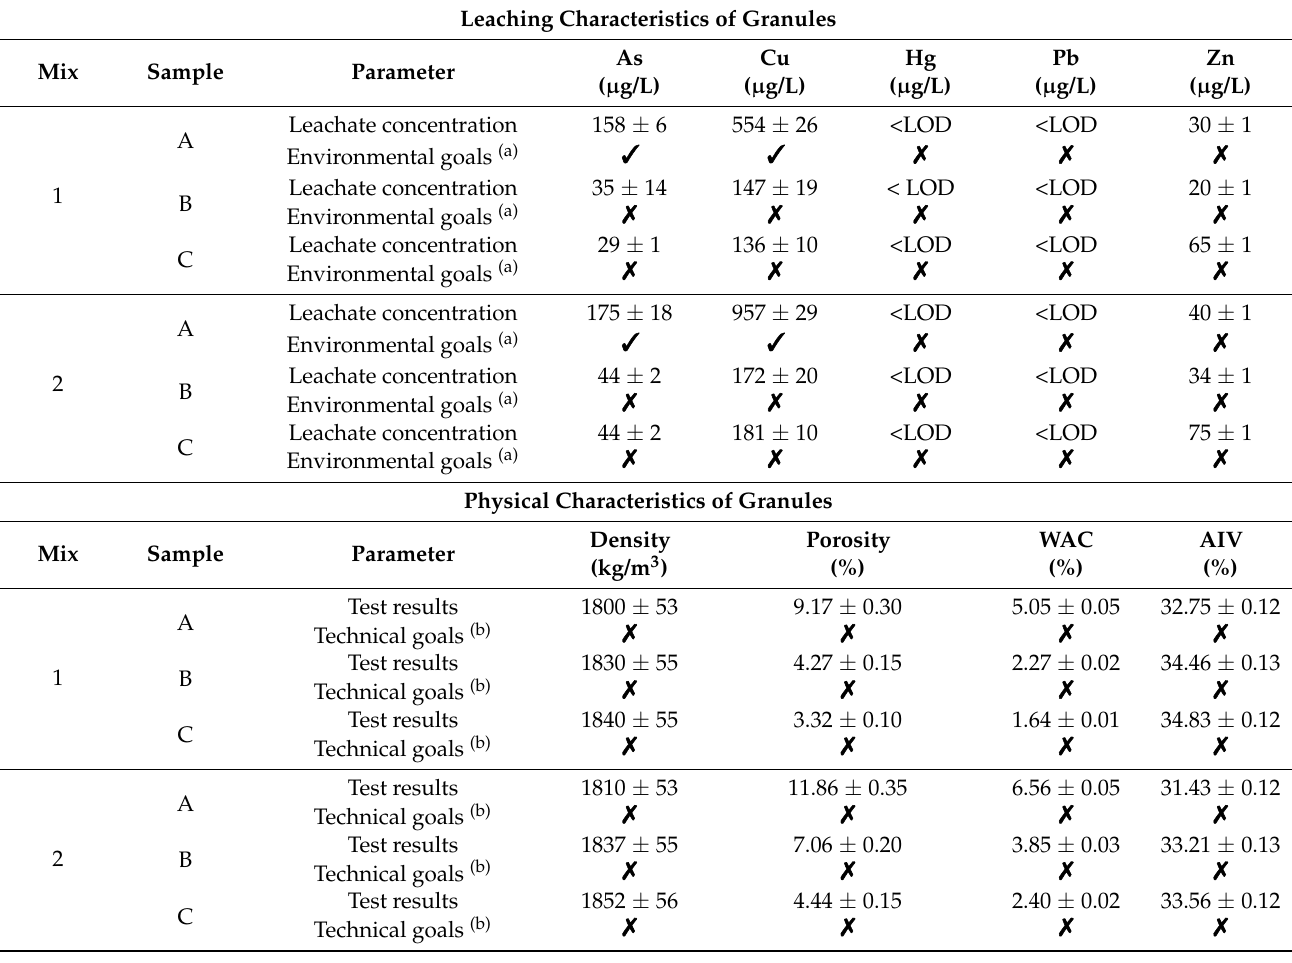
Table 4. Twenty-eight-day performances of aggregates.